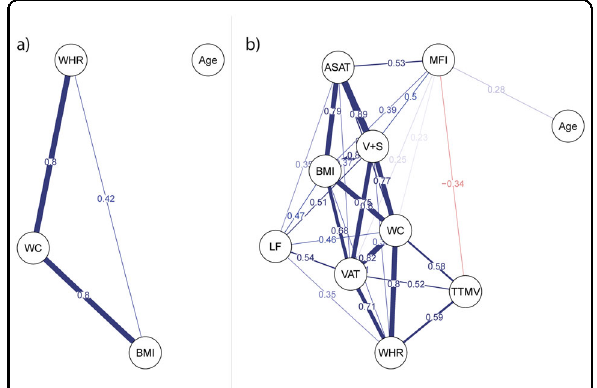
Fig. 1 Network correlation graphs of anthropometric and body composition measures and age. The network graphs visualize the structure of the correlation matrices of anthropometric and body composition measures and age; for ( a ) the full sample ( n = 24,728) and ( b ) the body MRI subsample ( n = 4973). It was created using the qgraph 34 R function (R version 4.0.0). The edges illustrate the correlation among variables, and the node placement re fl ects the correlation pattern. Only correlations with r ≥ 0.2 are displayed. ASAT abdominal subcutaneous adipose tissue, BMI body mass index, LF liver proton density fat fraction, MFI muscle fat in fi ltration, TTMV total thigh muscle volume, VAT visceral adipose tissue, V + S total abdominal adipose tissue (VAT + ASAT), WC waist circumference, WHR waist-to- hip